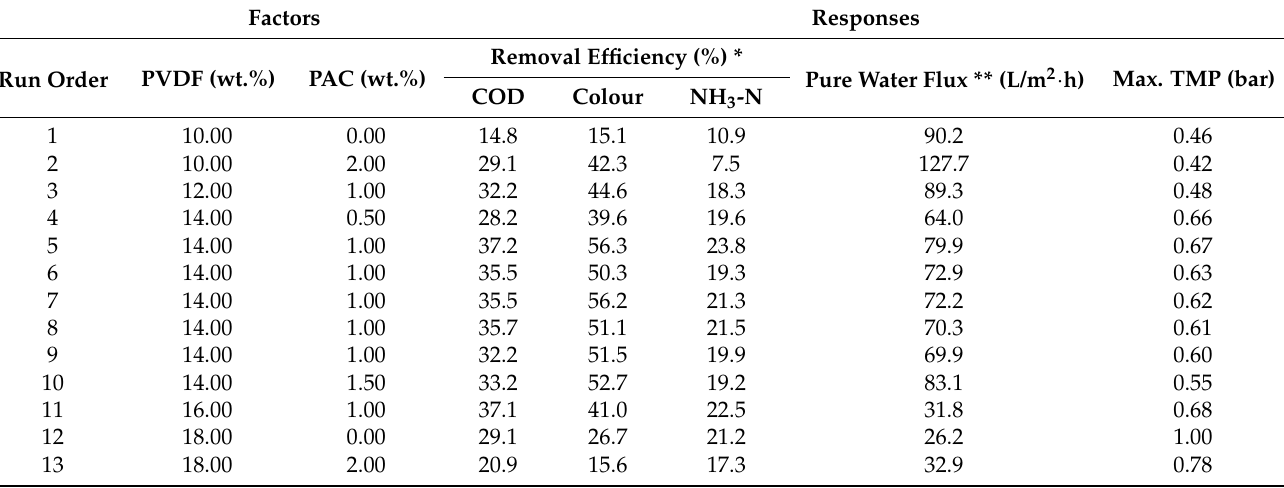
Table 2. Experimental results for the PVDF-PAC membranes (RSM design).